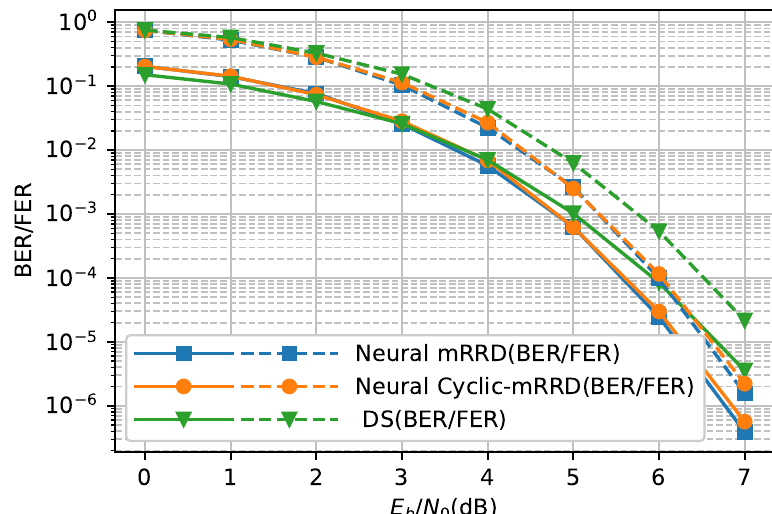
Figure 8. BER/FER performance of different decoders for the (47,24) QR code.